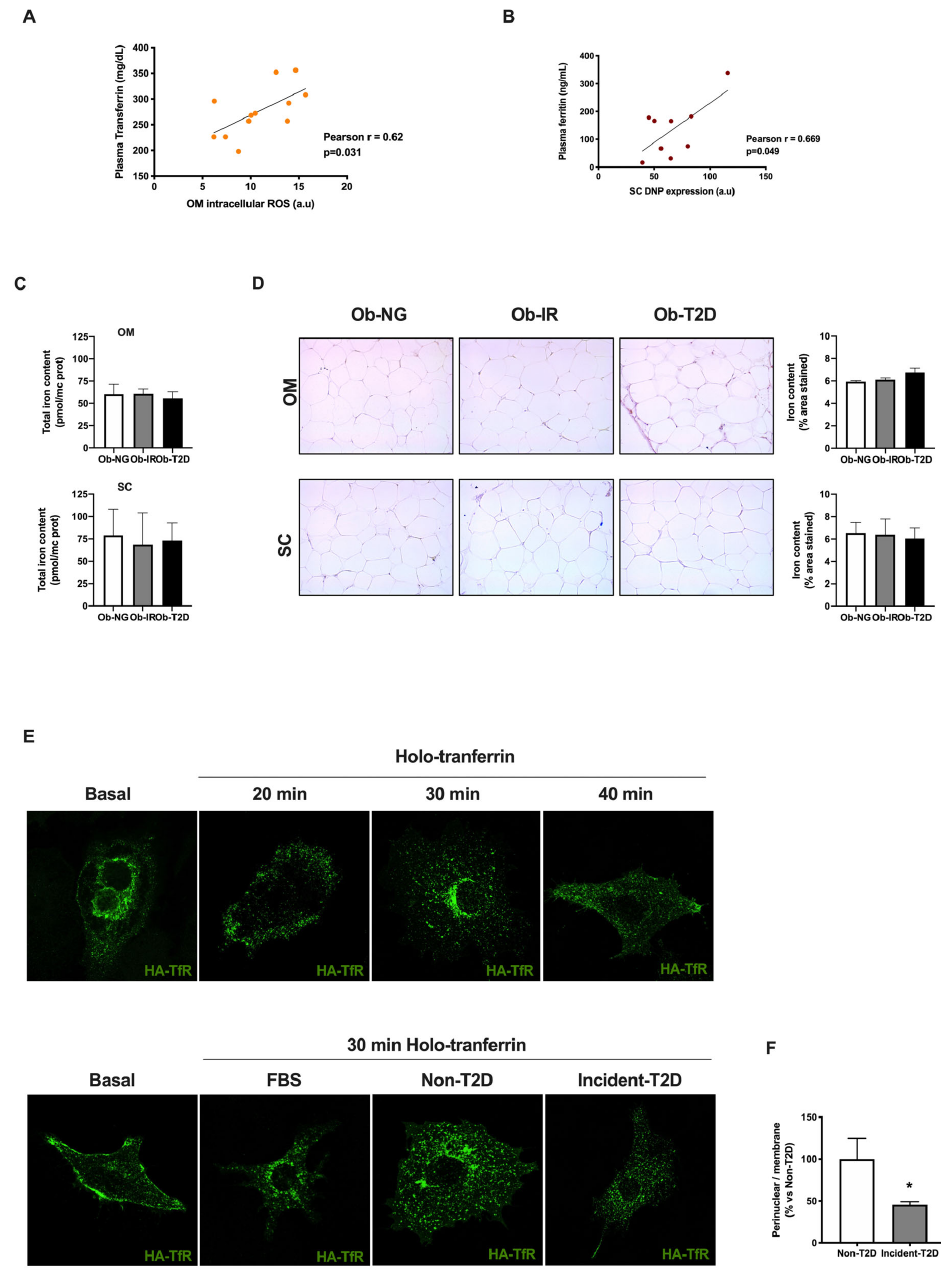
Figure 4. The effect of obesity and insulin resistance on iron homeostasis in human adipose tissue. ( A ) Correlation between plasma transferrin and OM intracellular ROS. ( B ) Correlation between plasma ferritin and SC DNP expression. ( C ) Total iron content in omental (OM) and subcutaneous (SC) human adipose tissue from obese normoglycemic (Ob-NG), insulin resistance (Ob-IR), or diabetic (Ob-T2D) subjects. ( D ) Prussian blue staining (left panel) and image and total area content (right panel) in OM (upper) and SC (lower) human adipose tissue. Representative confocal micrographs of transferrin receptor conjugated with anti-HA (HA-TfR) translocation in 3T3-L1 adipocytes in basal conditions or after holo-transferrin stimulus. ( E ) Representative confocal micrographs of transferrin receptor conjugated with anti-HA (HA-TfR) translocation in 3T3-L1 adipocytes exposed to FBS (control) or sera from non-T2D or incident T2D subjects, in basal conditions or after 30 min of holo-transferrin stimulus. ( F ) Quantification of ratio perinuclear reticular structures/ membrane labeling intensity of confocal images (8–10 micrographs/condition). * p < 0.05 vs. non-T2D using unpaired t